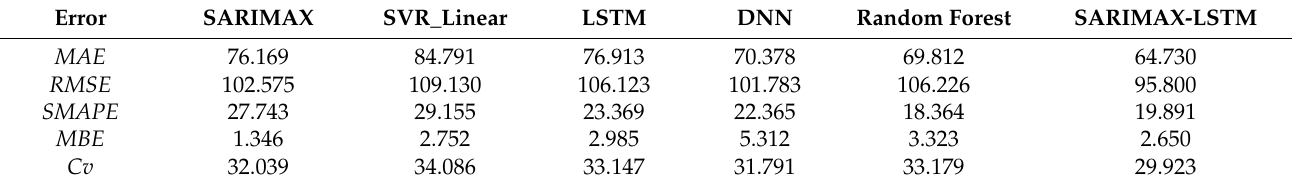
Table 14. The multisite solar PV generation prediction results of the proposed model. Error SARIMAX